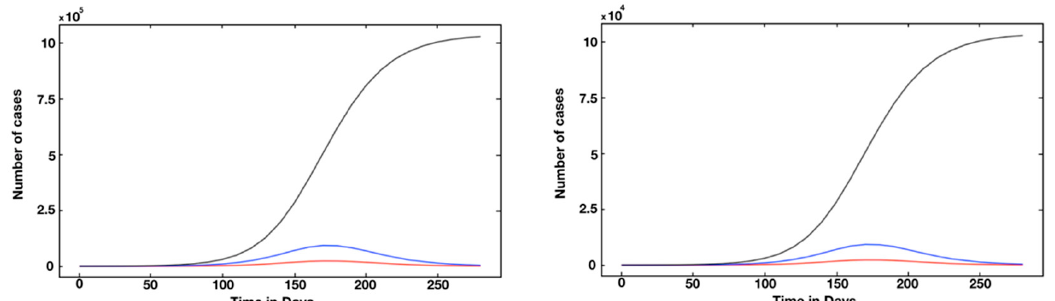
Figure 6. Simulated epidemiological curve without intervention. In this figure, we use f = 0.8, ν = 1/7, η = 1/7, and 𝑆 (cid:2868) = 2.881 × 10 (cid:2874) . The number of confirmed cumulative cases t → C ( t ) (black line) and t → U ( t ) the unreported cases (blue line) and (red line) correspond to the reported cases in Qatar. We use 𝜒 (cid:2869) = 215.08, 𝜒 (cid:2870) = 0.08, 𝜒 (cid:2871) = 145.48, 𝑡 (cid:2868) = − 4.88 and 𝑆 (cid:2868) = 2.881 × 10 (cid:2874) . The left side shows the curve without intervention, which gives τ = 7.1 × 10 (cid:2879)(cid:2876) . The right side shows the curve with a moderate intervention, which means τ = 7.1 × 10 (cid:2879)(cid:2876) for t ∈ [0, 150] and τ = 6.1 × 10 (cid:2879)(cid:2876) for t > 150.